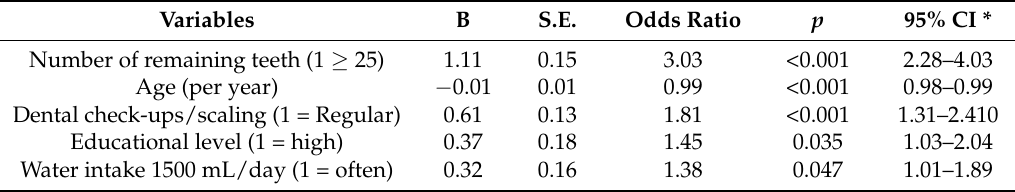
Table 3. Factors associated with perception good of oral health status.